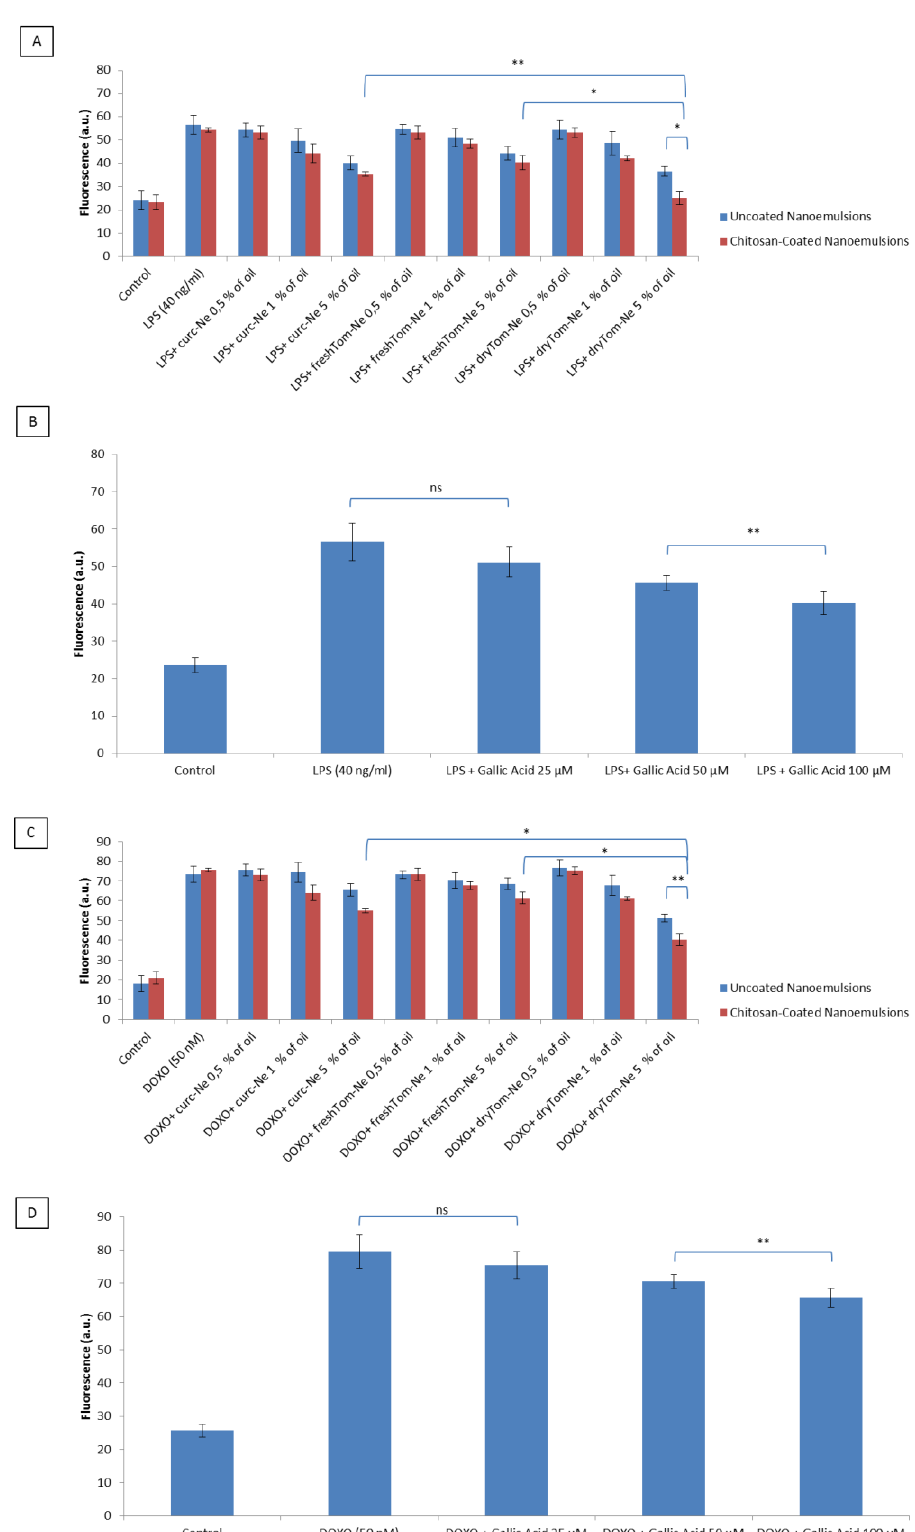
Figure 6. Detection of intracellular reactive oxygen species by fluorescence (a.u) in the H9c2 cell line (5000 cells/well). Cells were pretreated or not with uncoated and chitosan-coated nutraceutical-loaded nanoemulsions for 4 h before stimulation with 40 ng/mL of lipopolysaccharide (LPS) ( A ) or 50 nM of doxorubicin ( C ) for 24 h. Gallic acid was also exposed to cardiomyoblasts as positive control before stimulation with LPS ( B ) or doxorubicin ( D ). * p < 0.001; ** p < 0.05.